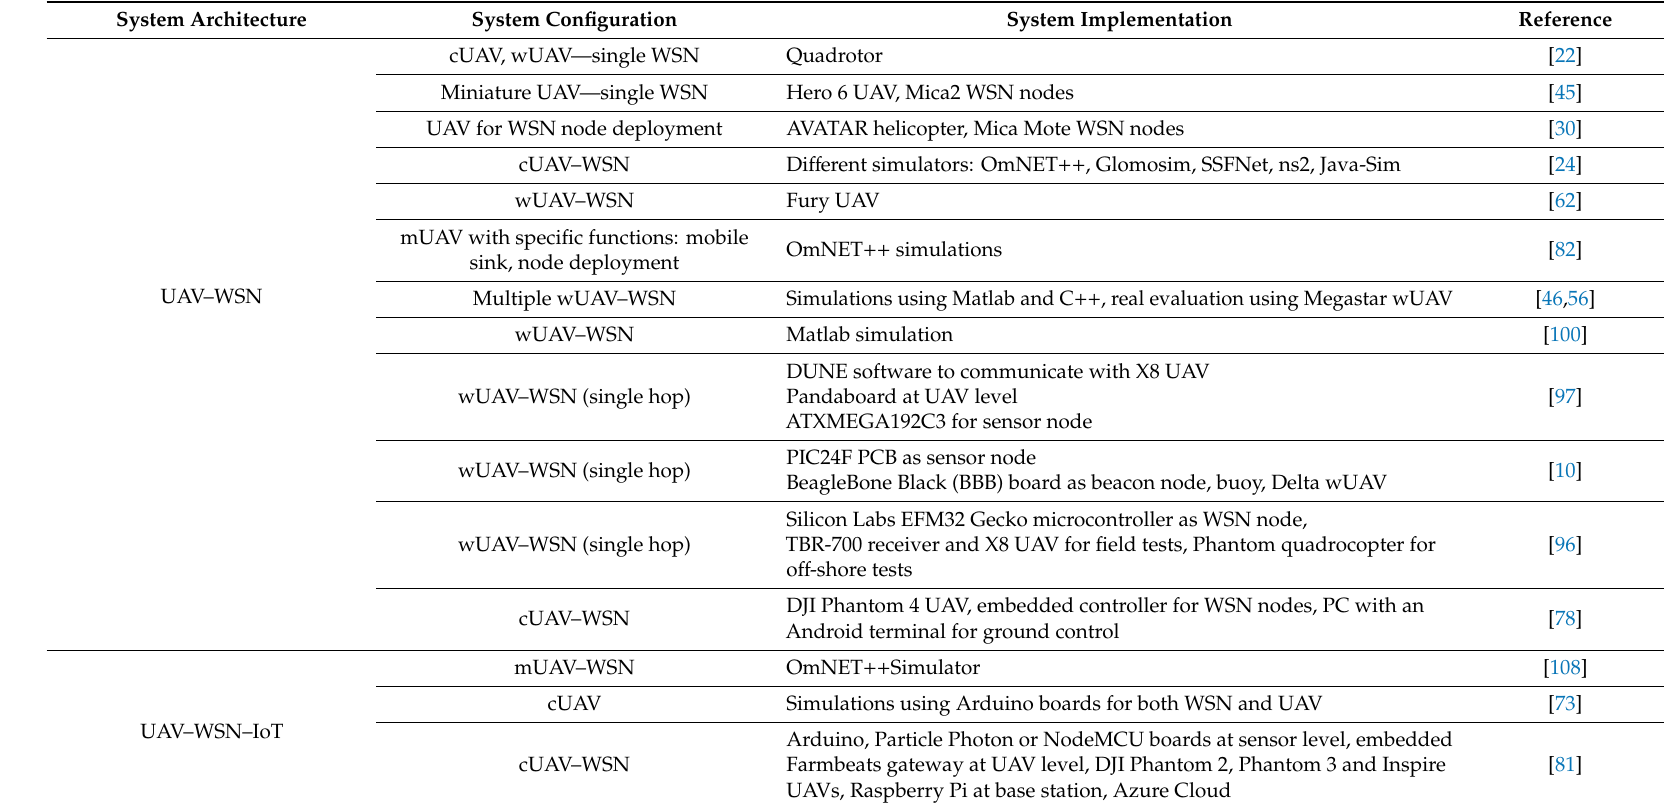
Table 4. Integrated UAV–WSN